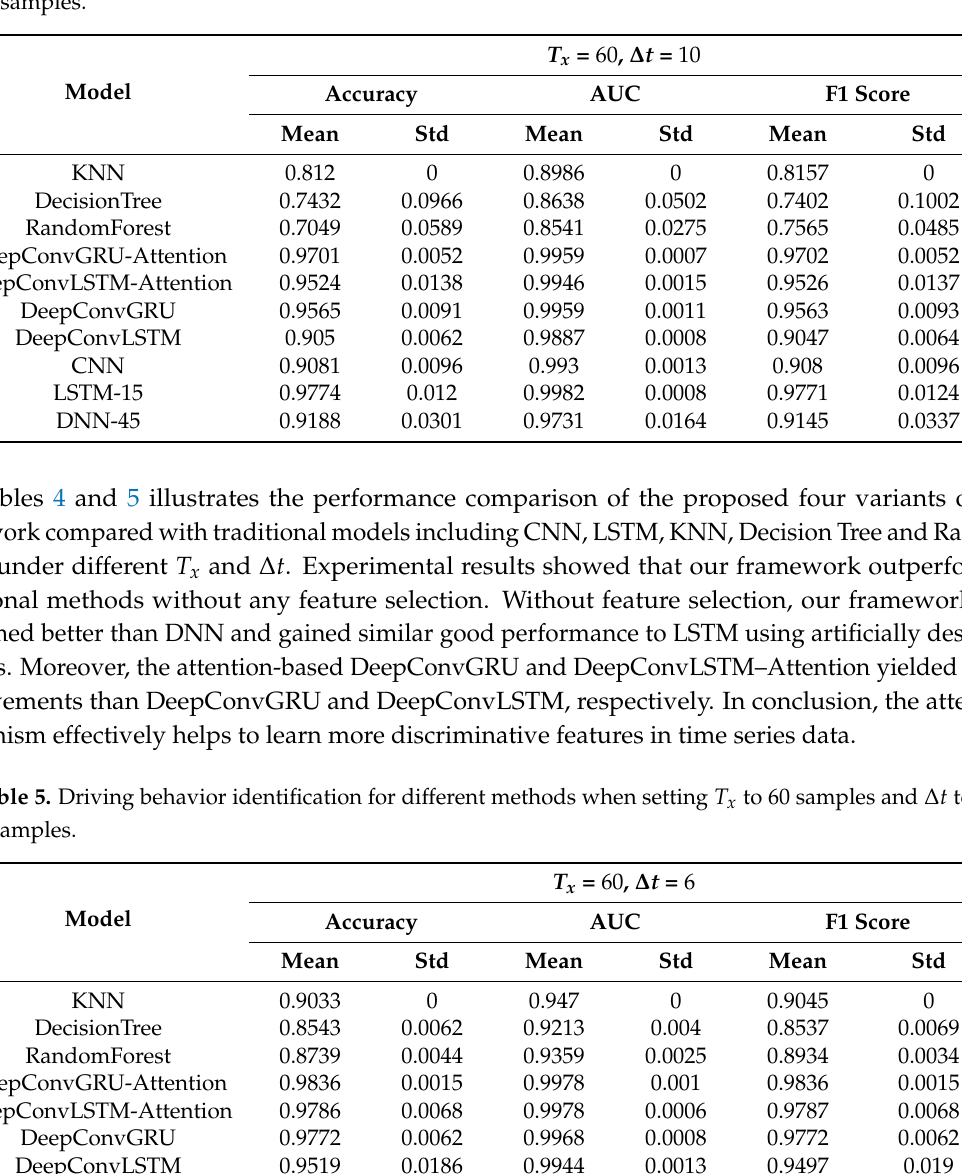
Table 4. Driving behavior identification for different methods when setting T x to 60 samples and ∆ t to 10 samples.